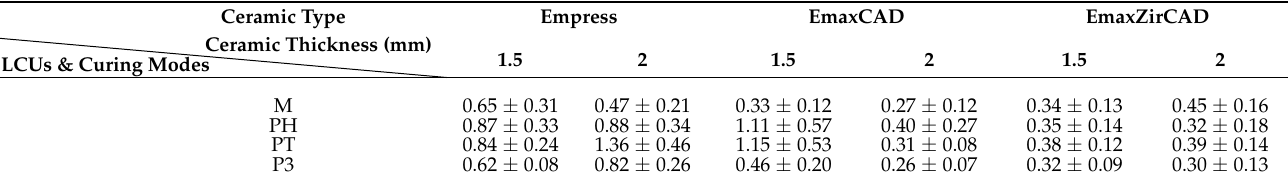
Table 2. Mean and standard deviation of interfacial bond strength (J/m 2 ) test